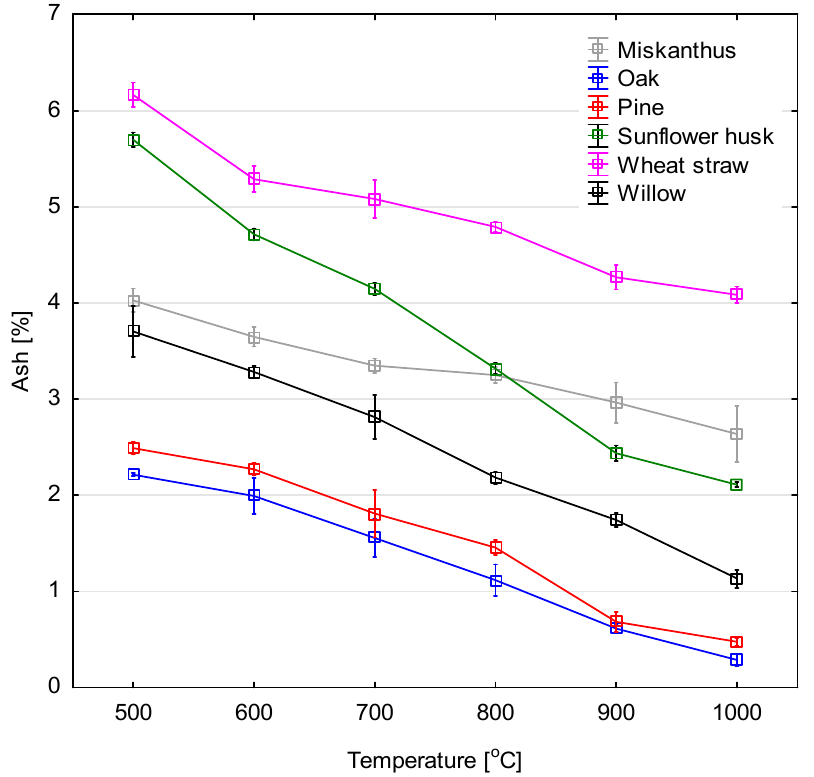
Figure 1. Changes in ash content in the examined biomass depending on ash-forming temperature.